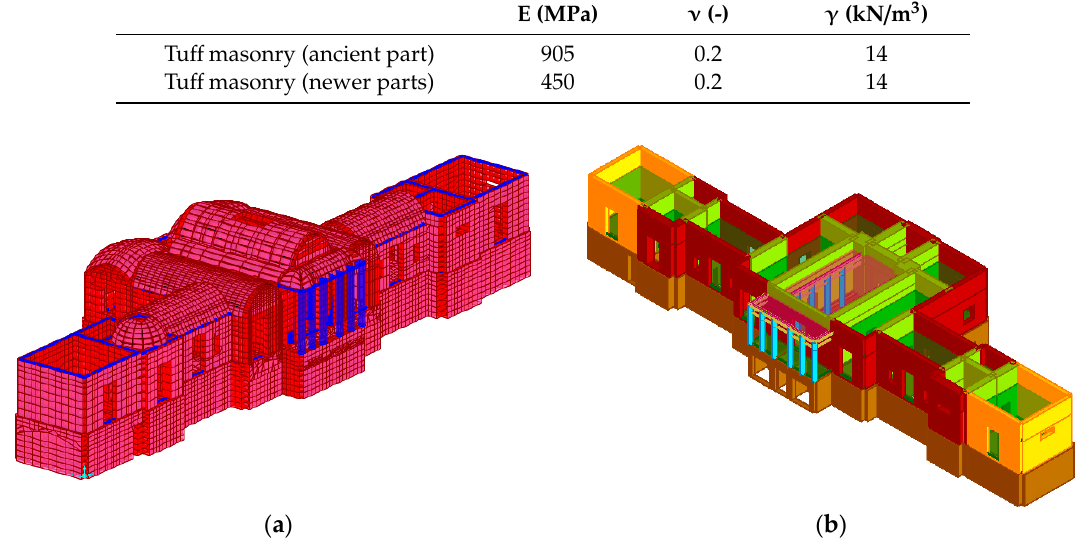
Figure 4. Maximum normal compression stresses in the main walls of the building (N/mm 2 ). The comparison between experimental data and the stress distributions obtained from linear analyses under gravity loads has been employed to verify the reliability of both the values adopted for the unit weight and the geometrical layout. In this case, the experimental value of 0.25 MPa obtained from the single flat-jack is in good agreement with the value of 0.22 MPa obtained by the numerical model.